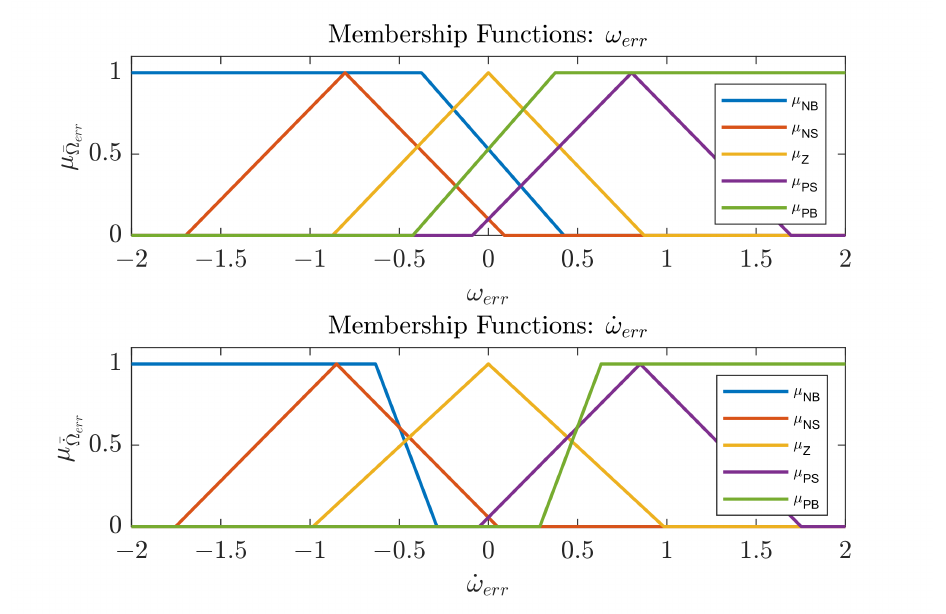
Figure 11. Membership functions obtained by